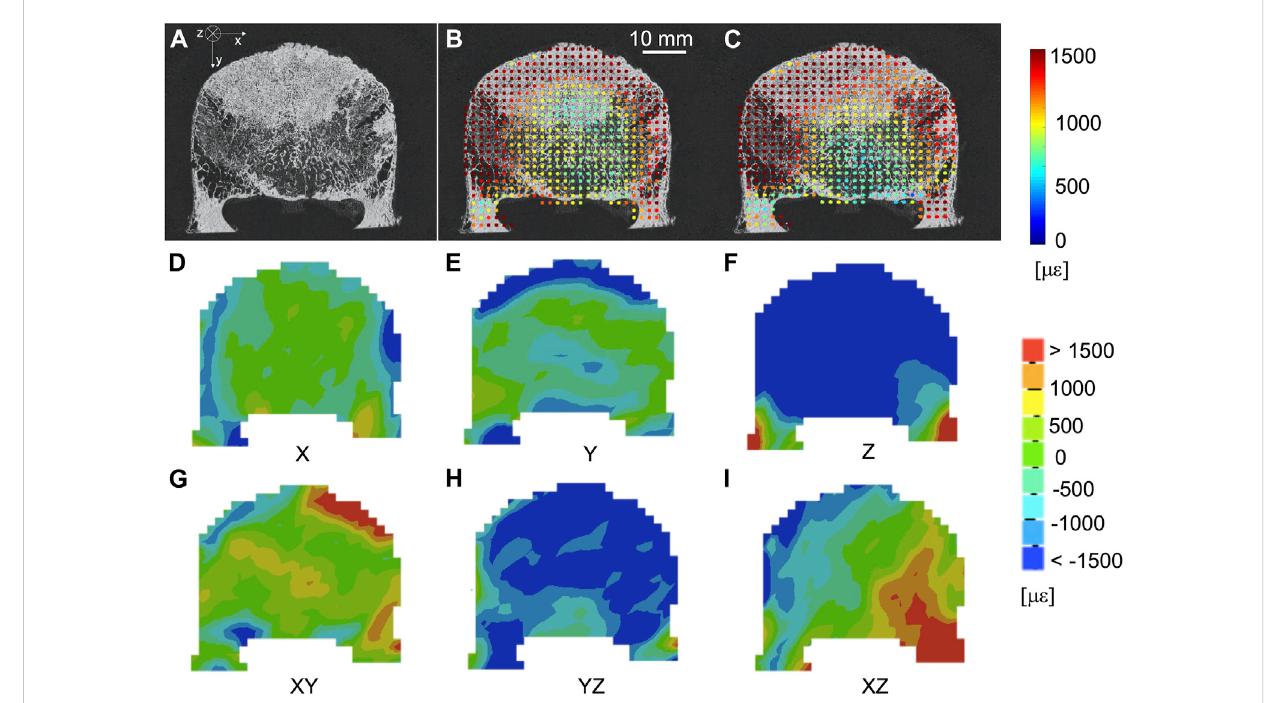
FIGURE 7 (A) microCT cross section of a vertebra with blastic metastases (indicated by a white arrow) in the anterior portion of the vertebral body. Spatial distribution of the mean (B) and standard deviation (C) of the absolute value of the six components of strain [ μ ε ] (NS = 50 voxels) on the same microCT cross section. From (D – I) spatial distribution of the six components of the strain [ μ ε ] (NS = 50 voxels) on the same microCT cross section.